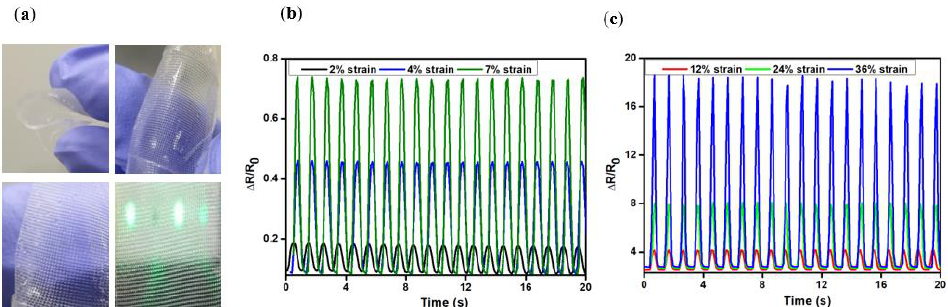
Figure 6. Printed mesh structure and gauge factor measurement. ( a ) Printed mesh structure flexibility and bending tests. The relative change in resistance as a function of the given tensile strain by the stretch and release processes during small ( b ) (2 – 7%) and large ( c ) (12 – 36%) strains.